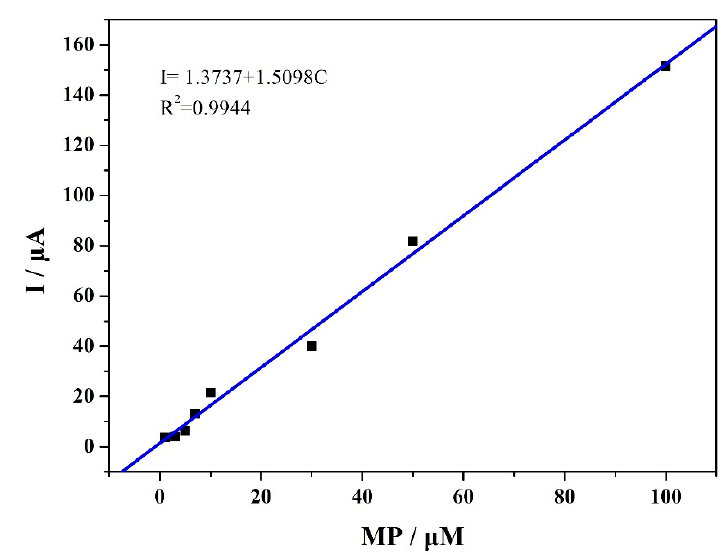
Figure 9. The linear relationship between the oxidation peak current and MP concentration (based on DPV). Table 1. Comparison of the performance between existing reports and this work.